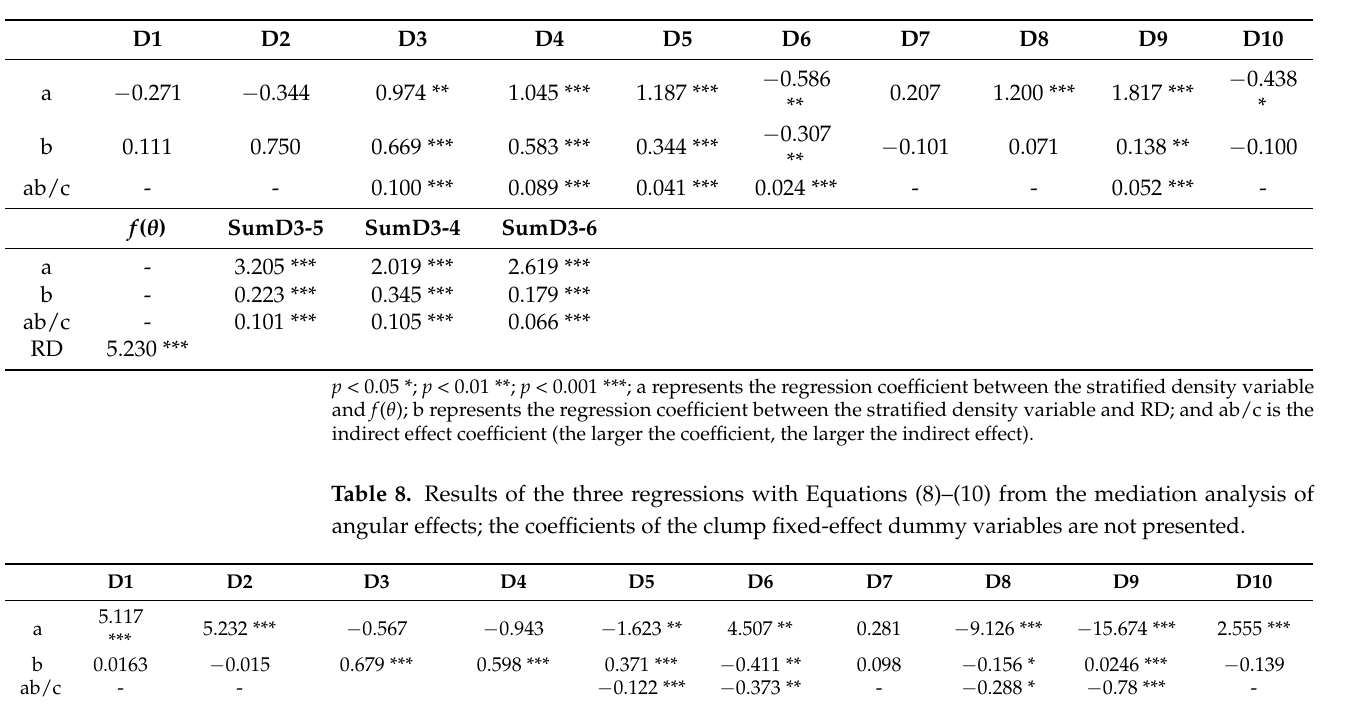
Figure 12. Statistics for the relative deviations ( a ) and standard deviations, and ( b ) of the angular effects change ratio. Table 7. Results of the three regressions with Equations (8)–(10) from the mediation analysis of angular effects; the coefficients of the clump fixed-effect dummy variables are not presented.